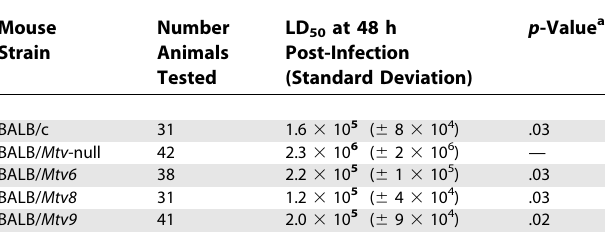
Table 2. Resistance of Mtv -Null Mice to Disease Induced by V. cholerae Is Abolished by the Presence of a Single Mtv Provirus Mouse Number Strain Animals